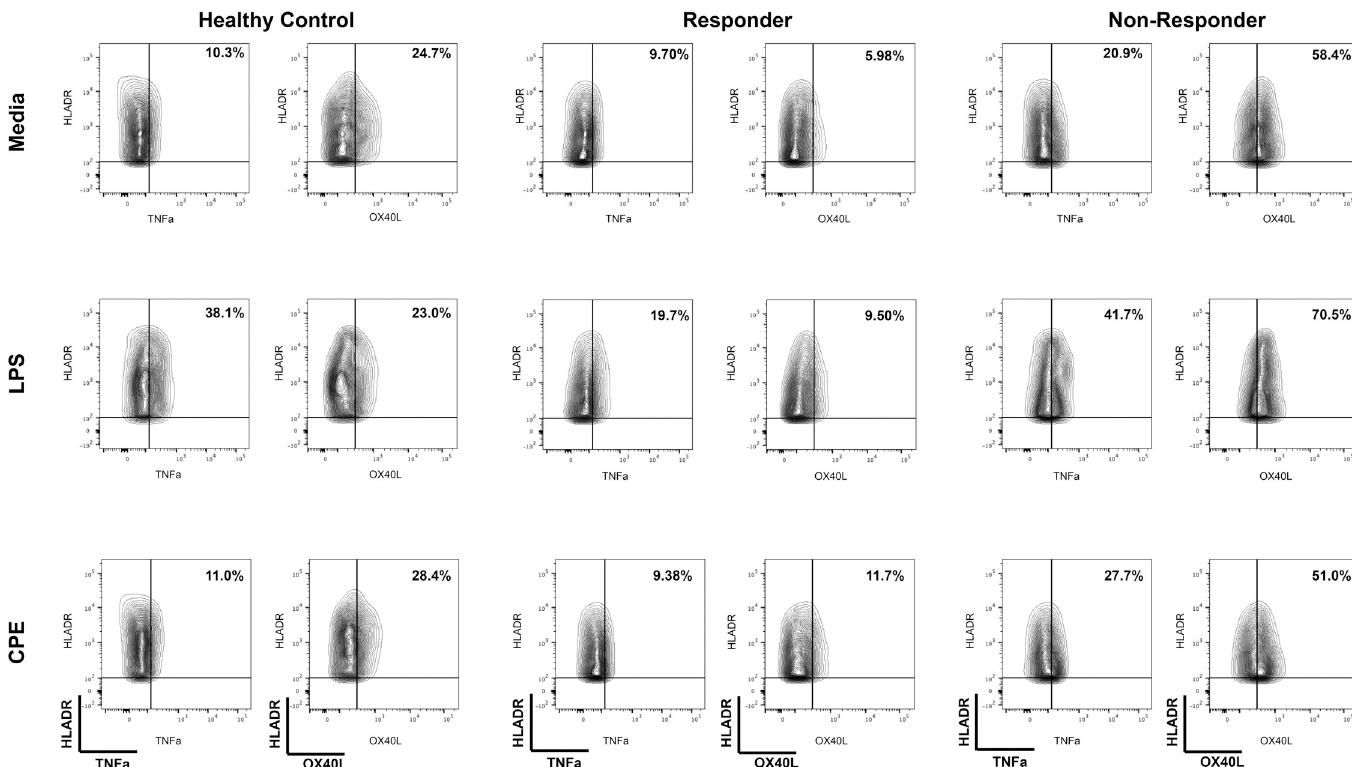
Fig 2. Gating strategy to identify OX40L and TNFa expression on myeloid dendritic cell (mDC) following stimulation with media, lipopolysaccharide (LPS), or crude peanut extract (CPE). (a) Baseline healthy control non-peanut allergic, (b) responder of peanut oral immunotherapy, and (c) non-responder of peanut oral immune therapy. Percentages of each population are based on the parent gate (CD14-HLADR+CD11c+ mDCs).